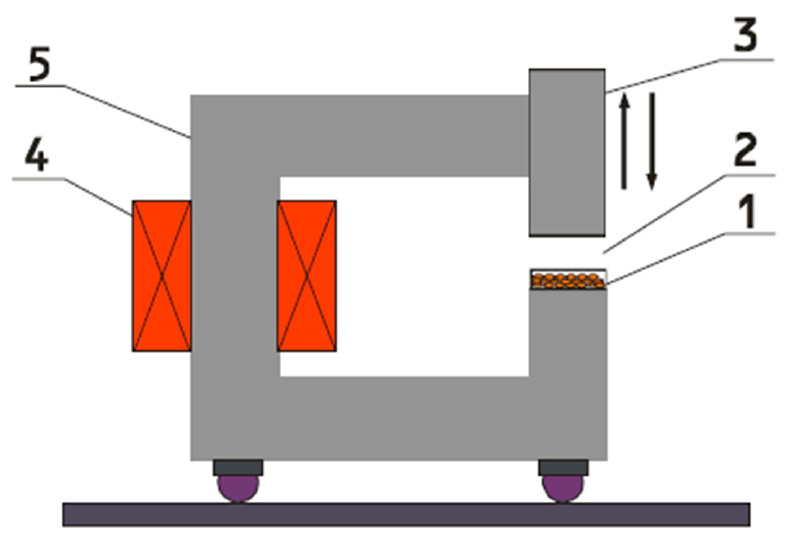
Figure 2. Seed stimulation station with FM. 1—container with seeds, 2—adjustable gap electromagnet, 3—moving armature, 4—windings of the solenoid, and 5—the solenoid. Source: [10].